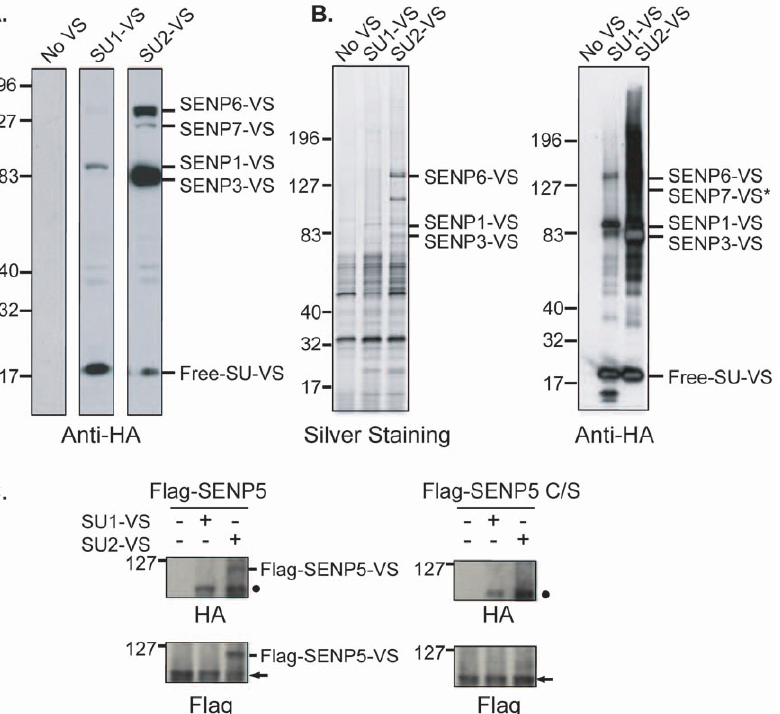
Figure 1. Abundance and paralogue preference of Ulp/SENP in XEEs. ( A ) XEEs were incubated with buffer (left), HA-SU1-VS (middle) or HA- SU2-VS (right), and subjected to SDS-PAGE and immunoblotting with anti-HA antibodies. Free SUMO vinyl sulfones and adducts with individual SENPs are indicated. ( B ) XEEs were incubated with buffer (left lanes), HA-SU1-VS (middle lanes) or HA-SU2-VS (right lanes). HA-tagged proteins were purified by affinity chromatography, resolved on SDS- PAGE and visualized by Silver staining (left panel) or by immunoblotting with anti-HA antibodies (right panel). Bands recognized by the anti-HA antibodies were identified by mass spectrometry as indicated to the right of each panel. ‘‘*’’ indicates that SENP7 was not identified by mass spectrometry, but could be readily detected by immunoblotting with an antibody specific to SENP7. ( C ) In vitro translated Flag-SENP5 and Flag-SENP5-C/S were incubated with HA-SU1-VS or HA-SU2-VS. The reactions were monitored by ’’ indicates the position of SENP1-VS in the upper panels. Arrow immunoblotting with anti-HA (Upper panel) or anti-Flag (Lower panel) antibodies. ‘‘ & indicates the position of unreacted Flag-SENP5 or Flag-SENP5-C/S.